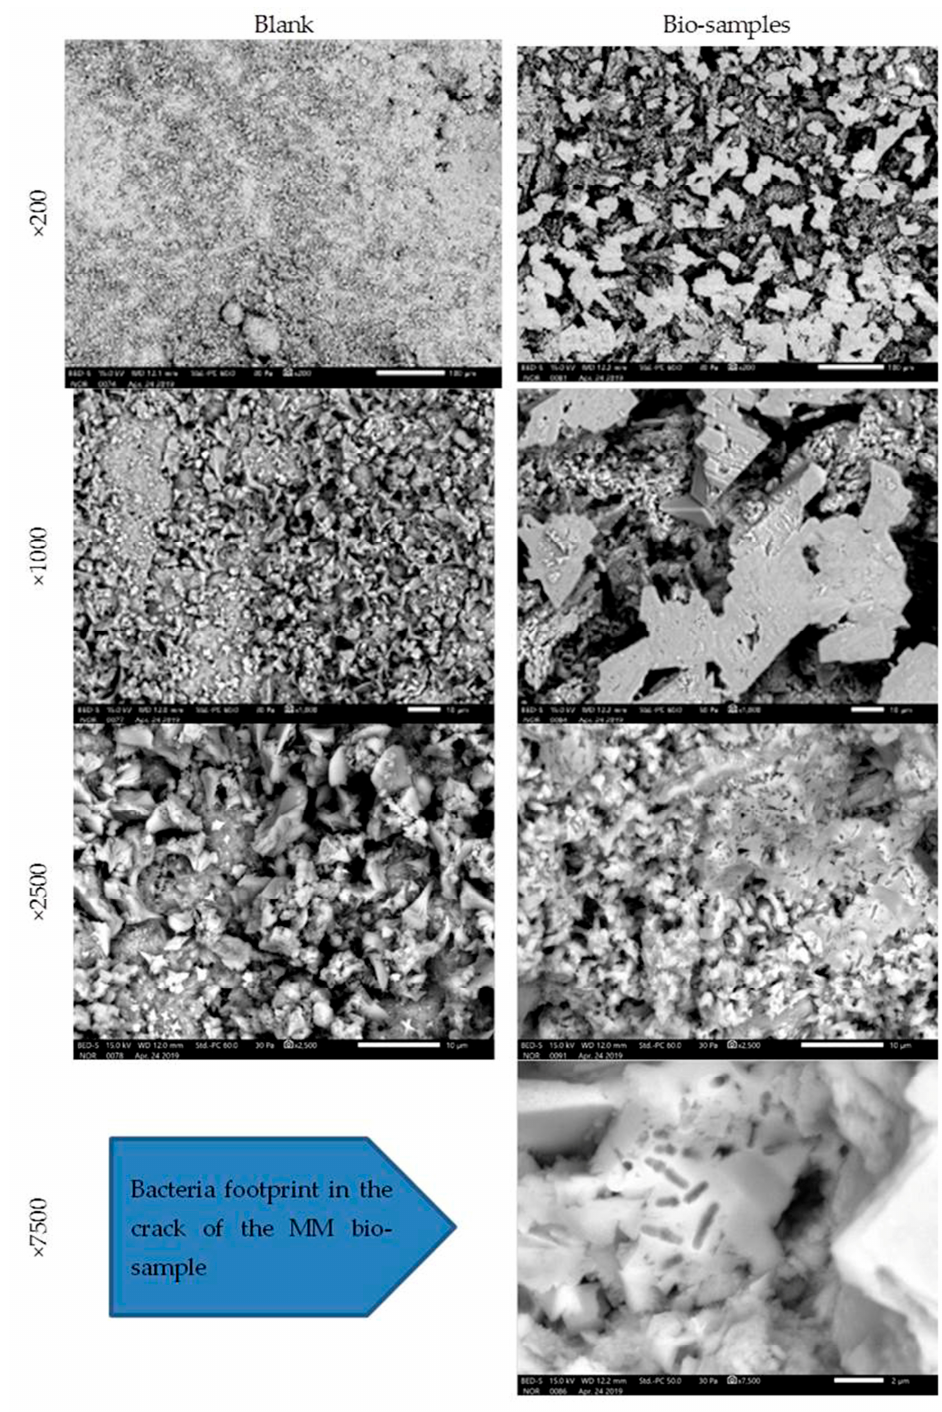
Figure 9. Microscopic images of MM bio- and blank samples after 28 days of incubation [6]. The obtained SEM images revealed evidence about the nature and structure of the precipitate. In the SEM images, the difference was easily observed between the blank and bio-samples of the MM after 28 days of incubation. The difference was in the clearly de- tectible presence of CaCO 3 crystals in the precipitate of the bio-samples. Under a magni-